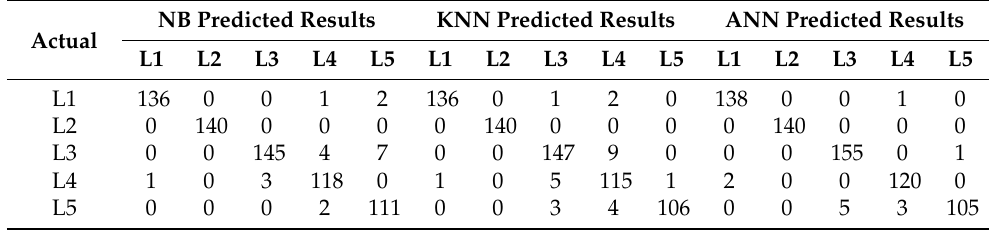
Table 3. Confusion matrix for five human